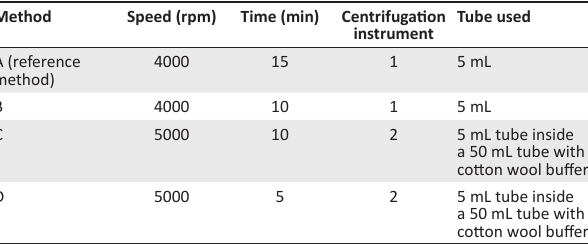
TABLE 2: Speed and time specifications for centrifugation methods, Inkosi Albert Luthuli Central Hospital and King Edward VIII Hospital, Durban,